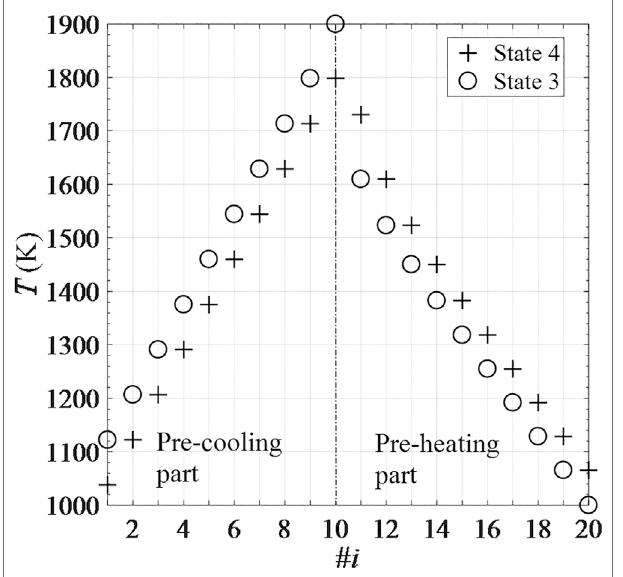
FIGURE 10 | Temperature distribution of 20 recuperation CRRs corresponding to State 3 and State 4 of one cycle under steady conditions.